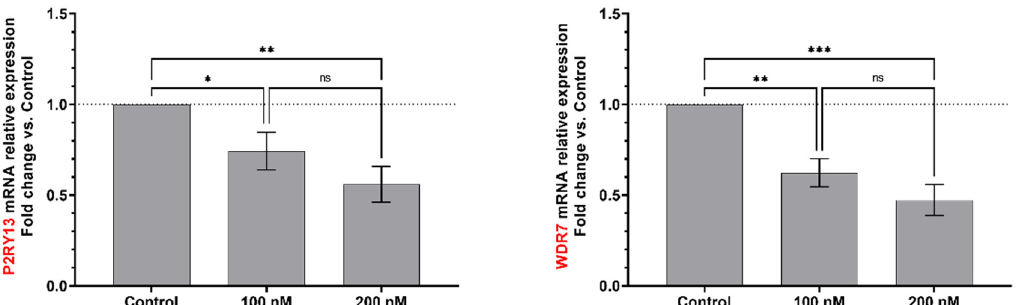
Figure 6. EBOV miR-MAK-403 may regulate several human host mRNA targets. INPPE5, STAG2, VAPA, SMURF2, CGRRF1, CDK13, WDR7 and P2YRY13 genes, which are potentially involved in viral infection mechanisms, were monitored by RT-qPCR (mRNA relative expression) after transfection of EBOV miR-MAK-403 mimic (100 and 200 nM) in Huh7 cells. qPCR data were normalized with a reference gene (ACTB), reported to control (mock control) and expressed with a relative quantitation method (ddCT). Statistical analysis: Data were calculated from three biological replicates and expressed as means ± SD. One-way analysis of variance (ANOVA) and Tukey’s multiple comparisons test were used, and statistically significant differences (fold change vs. control) are indicated as follows: * p < 0.05; ** p < 0.01; *** p < 0.001; **** p < 0.0001. ns, non